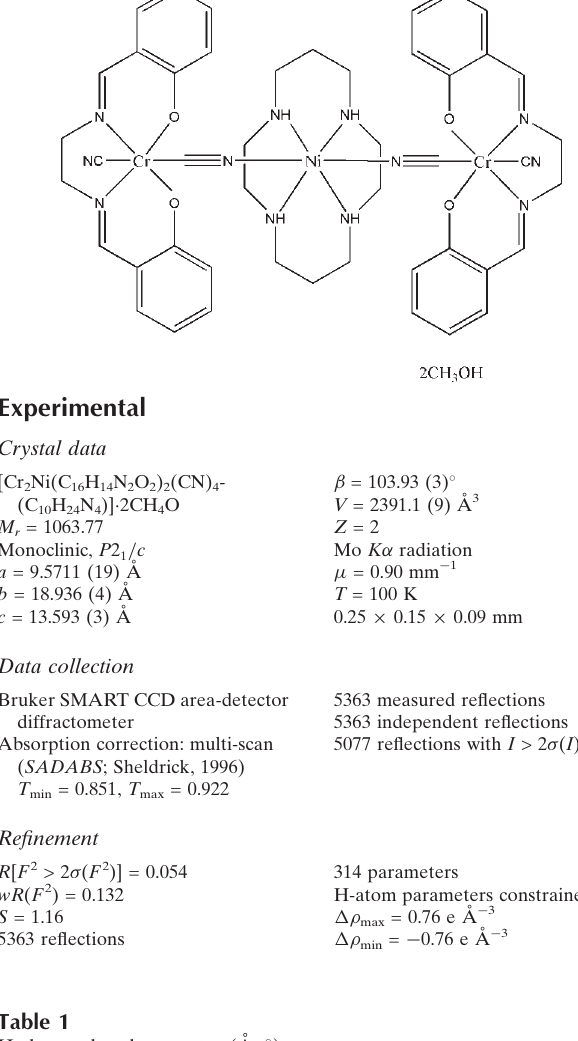
Hydrogen-bond geometry (A˚ , (cid:3)